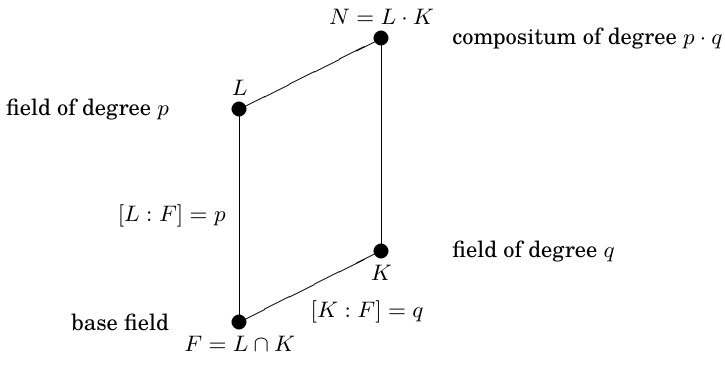
Figure 2: Hasse subfield diagram of N/F